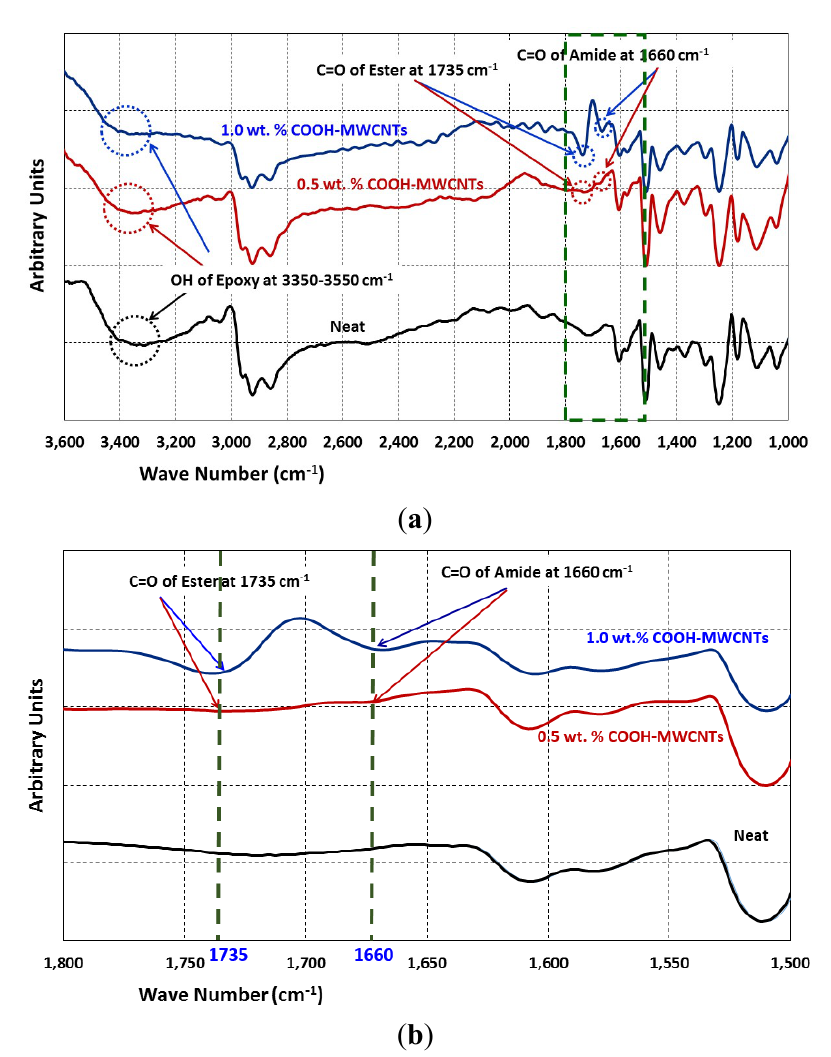
Figure 10. FTIR spectrum for the epoxy incorporating 0 wt% (neat), 0.5 wt%, and 1.0